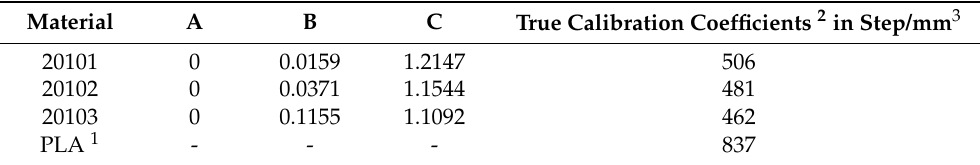
Table 2. Compensation parameters and calibration coefficients for the used